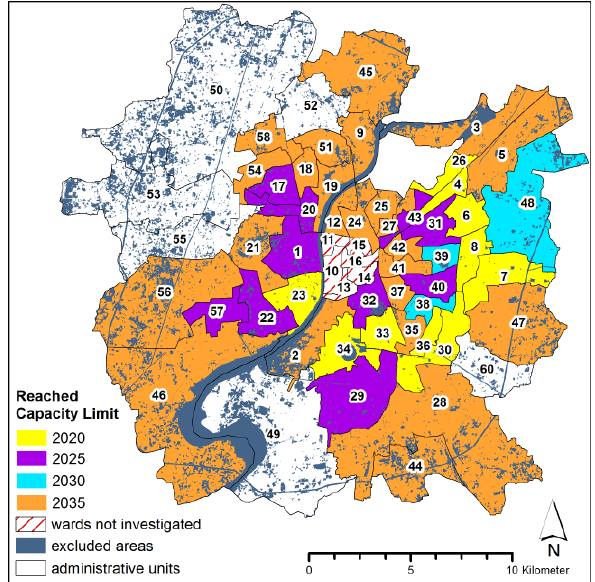
Figure 8: Capacity limits of different wards of the AMC